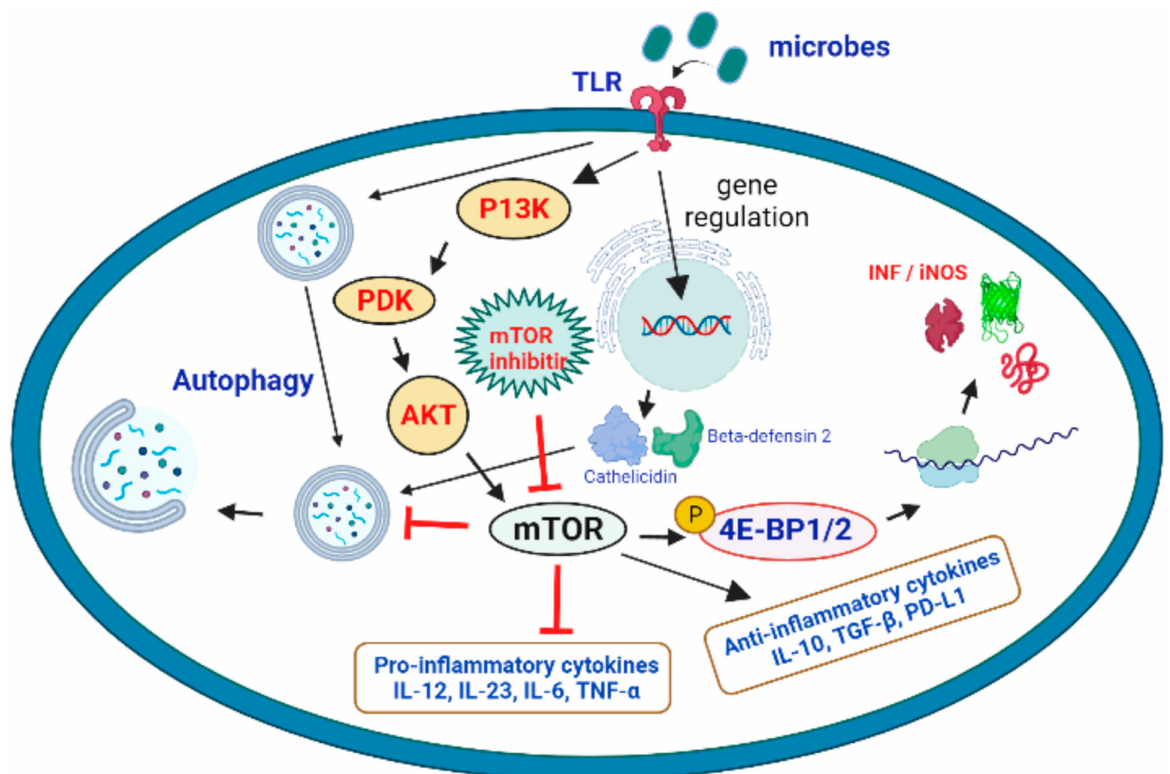
Figure 3. Activation of the mTOR pathway and its potential role in the targeting of microbial infections. Microbial interaction with TLRs activates the P13K > PDK > AKT > mTOR cascade, which results in mTOR activation. It promotes protein translation and the production of iNOS and interferons by phosphorylating 4E-BP1/2 (eukaryotic translation initiation factor 4E binding protein 1 and 2). Microbial detection also promotes autophagy by causing the expression of beta-defensin 2 and cathelicidin. Because mTOR inhibitor is an autophagy inhibitor, it can promote autophagy and fight microbial